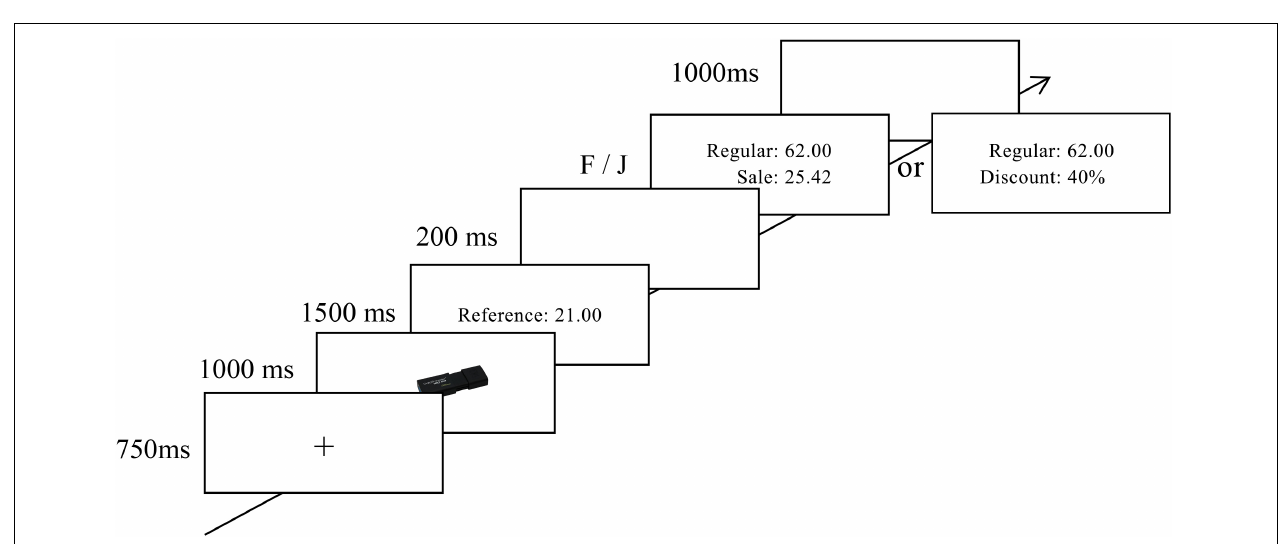
FIGURE 1 | Illustration of one trial. Range of reference price, regular price and sale prices are 20 to 100 yuan. And that of discount is 20% to 90%.